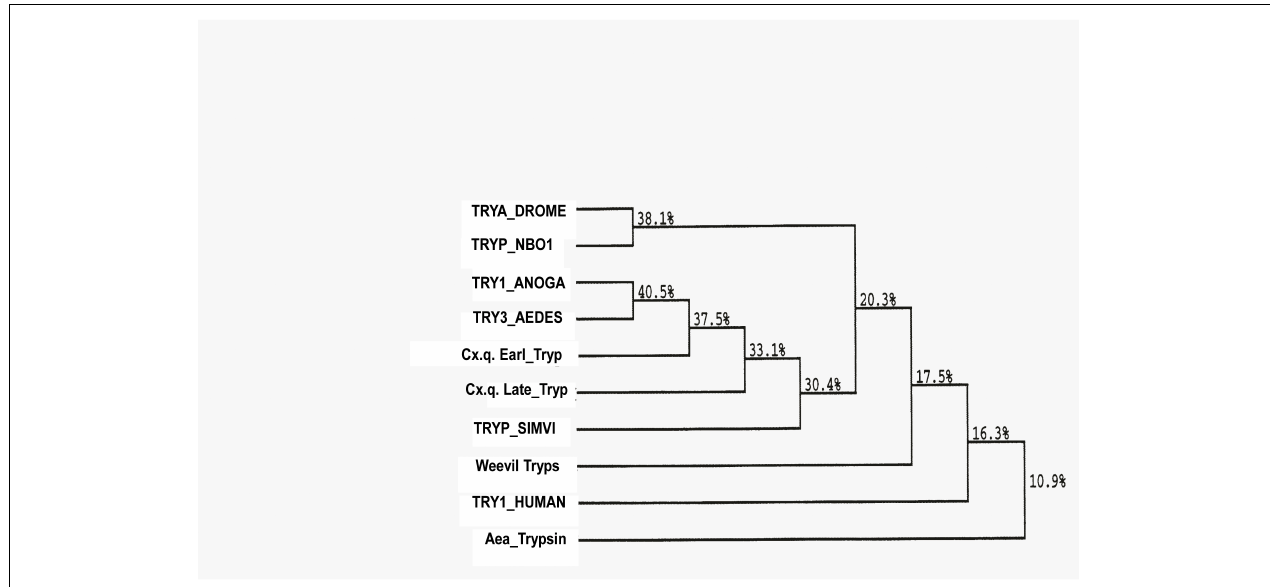
FIGURE 5 | Phylogenetic tree based on multiple alignments according to the Higgins–Sharp algorithm (Clustral 4) of DNAStar v.12. The branching order similarities (%) are based on sequences found at the GenBank.